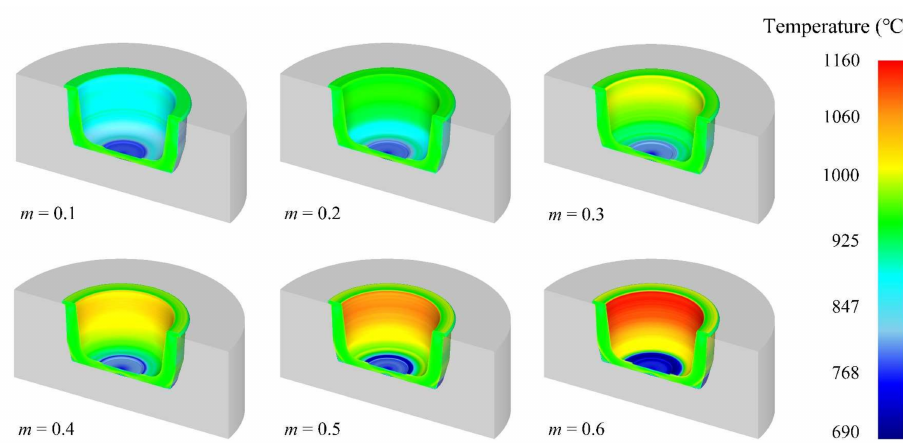
Figure 3. Distributions of temperature under various friction